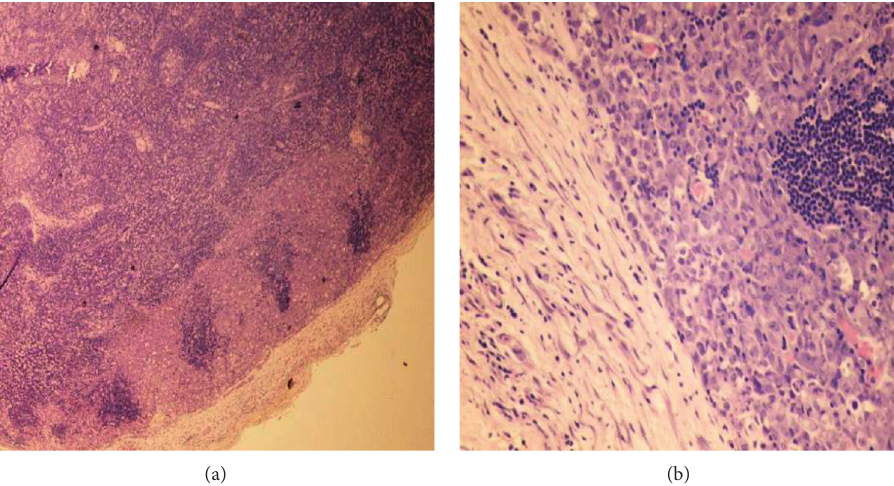
Figure 6: (a) At low magnification, focal effacement of lymph node architecture by cohesive infiltrate of neoplastic cells, extending from the subcapsular sinuses into the paracortical region. (b) At high magnification, large pleomorphic neoplastic cells with abundant eosinophilic cytoplasm, pleomorphic nuclei, and frequent mitotic figures, including a “hallmark” cell with horseshoe-shaped nuclei (blue